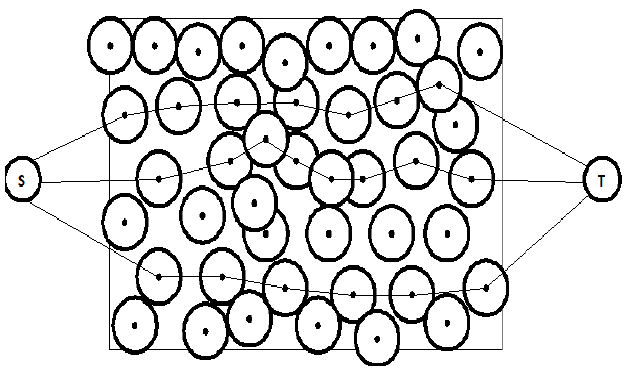
Figure 2. Barrier